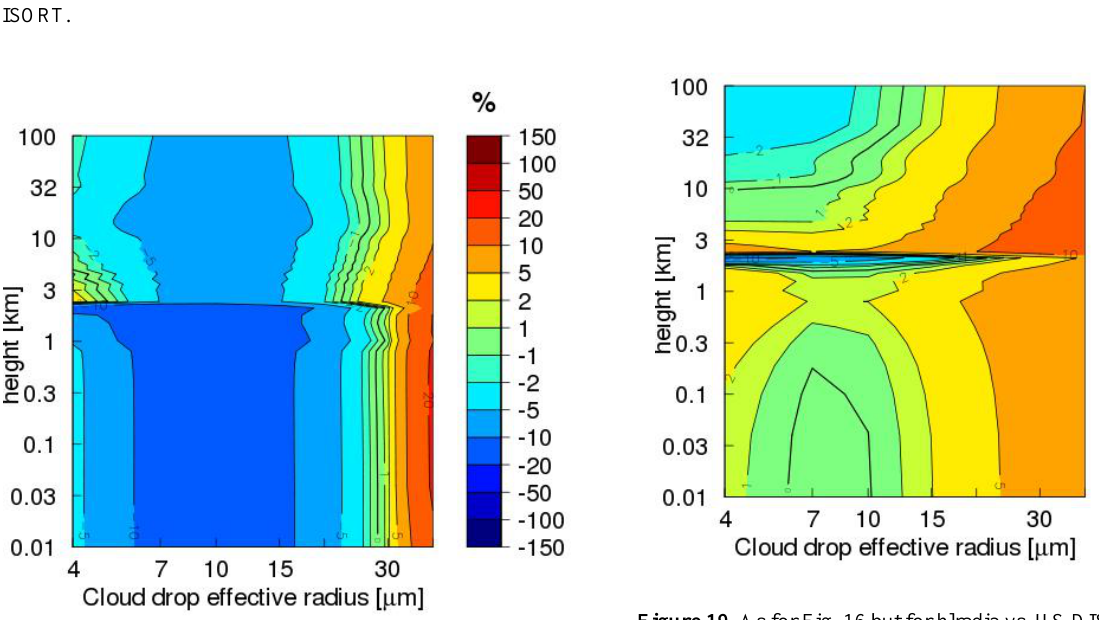
Figure 19. As for Fig. 16 but for hlradia vs.